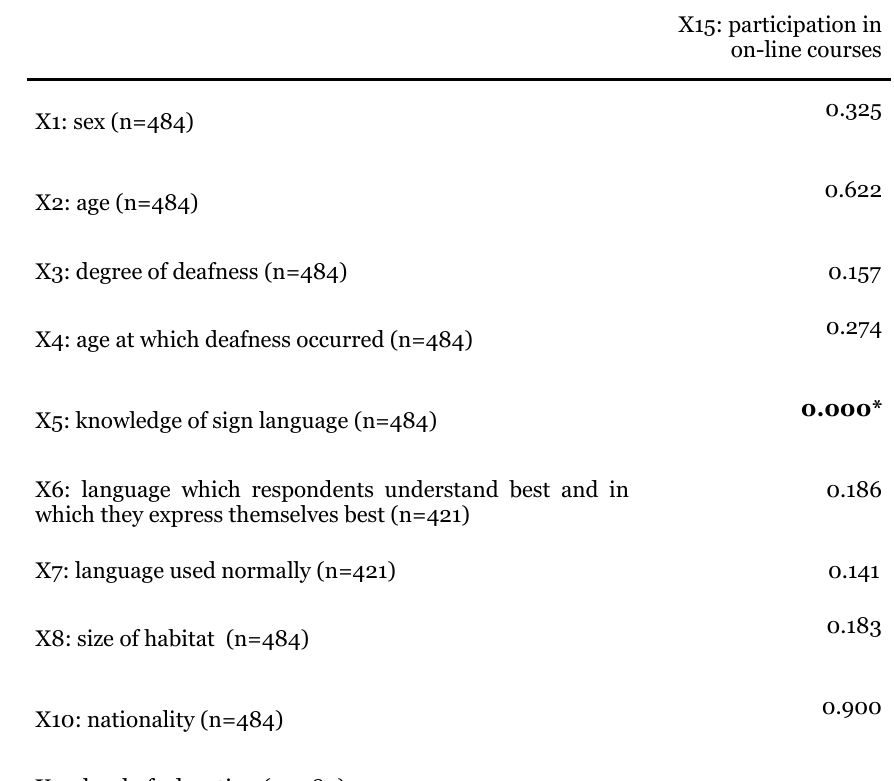
P-Values of the Chi-Squared Tests for Independence